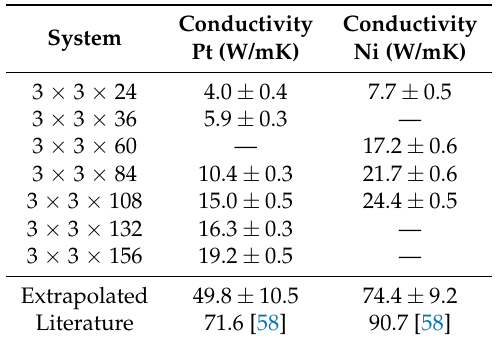
Table 2. Thermal conductivities for different system sizes of Pt and Ni. Conductivity System